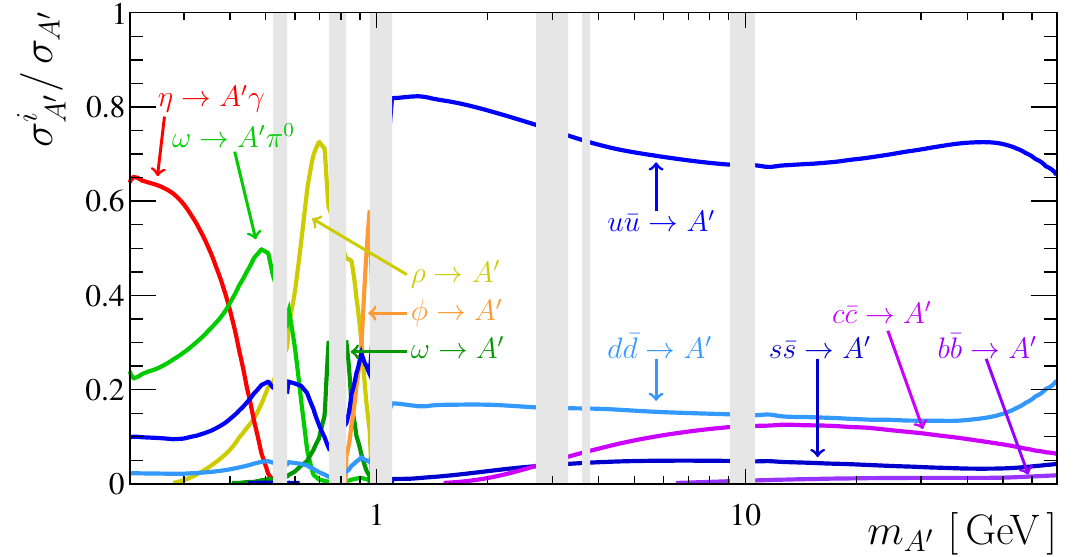
Figure 11 . Dark-photon production fractions for the most important processes at LHCb in the (cid:12)ducial region of ref.